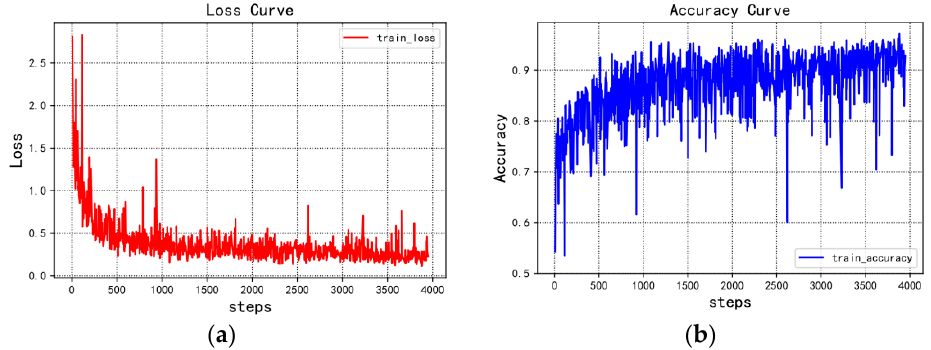
Figure 15. Point cloud segmentation training process. ( a ) Loss curve; ( b ) Accuracy